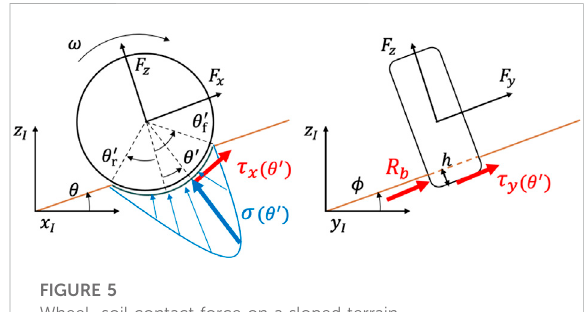
FIGURE 6 Characteristic diagram of vehicle slippage ( δ =10 °